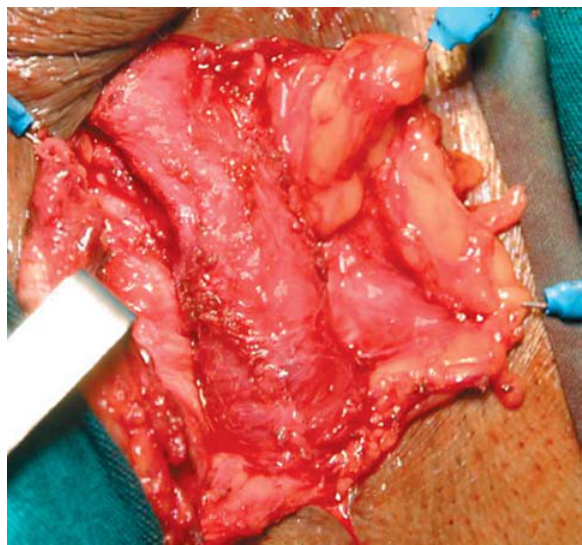
Figure 5 – Final aspect of the tunica vaginalis urethroplasty. The graft is completely covered by the